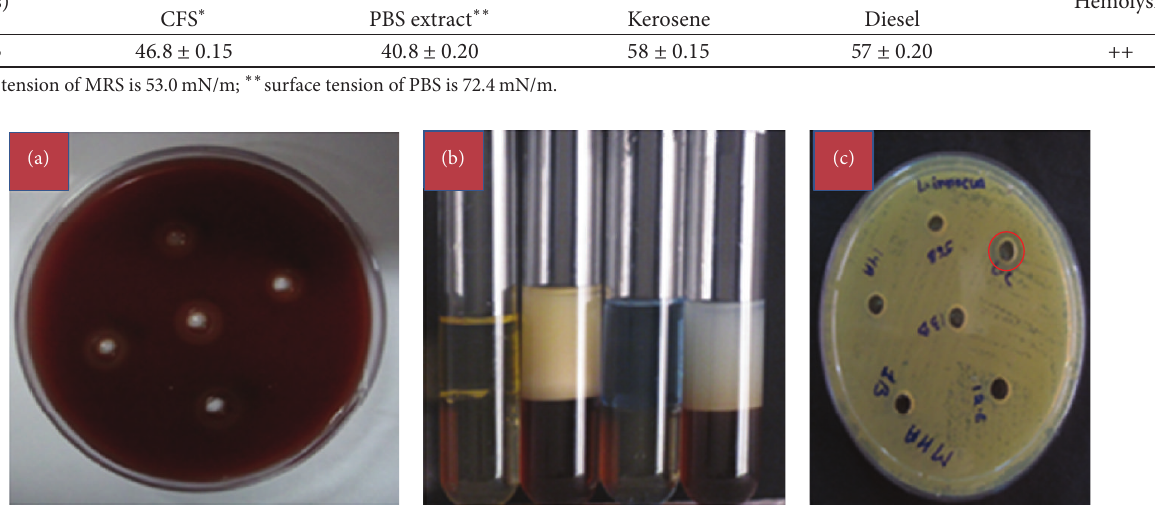
Figure 1: Biosurfactant and bacteriocin production. (a) Hemolysis on blood agar plates. (b) Emulsification of kerosene and diesel oil by culture supernatant. (c) Bacteriocin activity against Listeria innocua